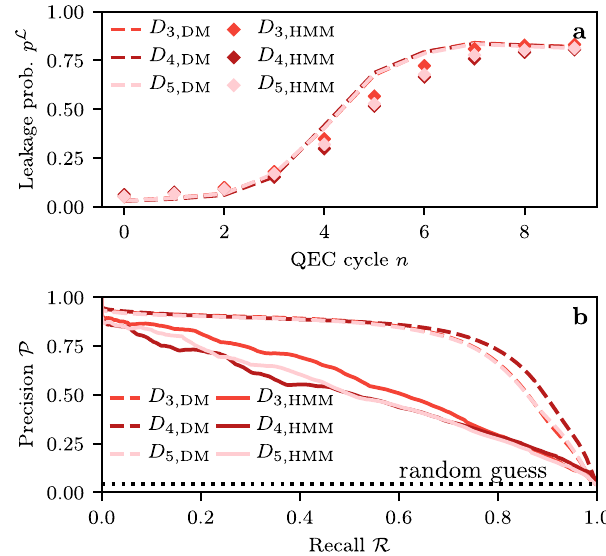
Fig. 5 Data-qubit leakage detection. a Average response in time of the HMMs (diamonds) to leakage, in comparison to the actual leakage probability extracted from the density-matrix simulations (dashed lines). The average is computed by selecting single Q ð Þ was below a threshold p L realizations where p L ¼ 0 : 5 for at DM th least 5 QEC cycles and then above it for 5 or more rounds. Error bars, estimated by bootstrapping, are smaller than the symbol sizes. b Precision-recall curves for the data qubits over 4 × 10 4 runs of 50 QEC cycles each using the HMM predictions (solid) and the leakage probability from the density matrix (dashed). The dotted line corresponds to a random guess classi fi er for which P is equal to the fraction of leakage events (occurring with probability given by the density matrix) over all QEC cycles and